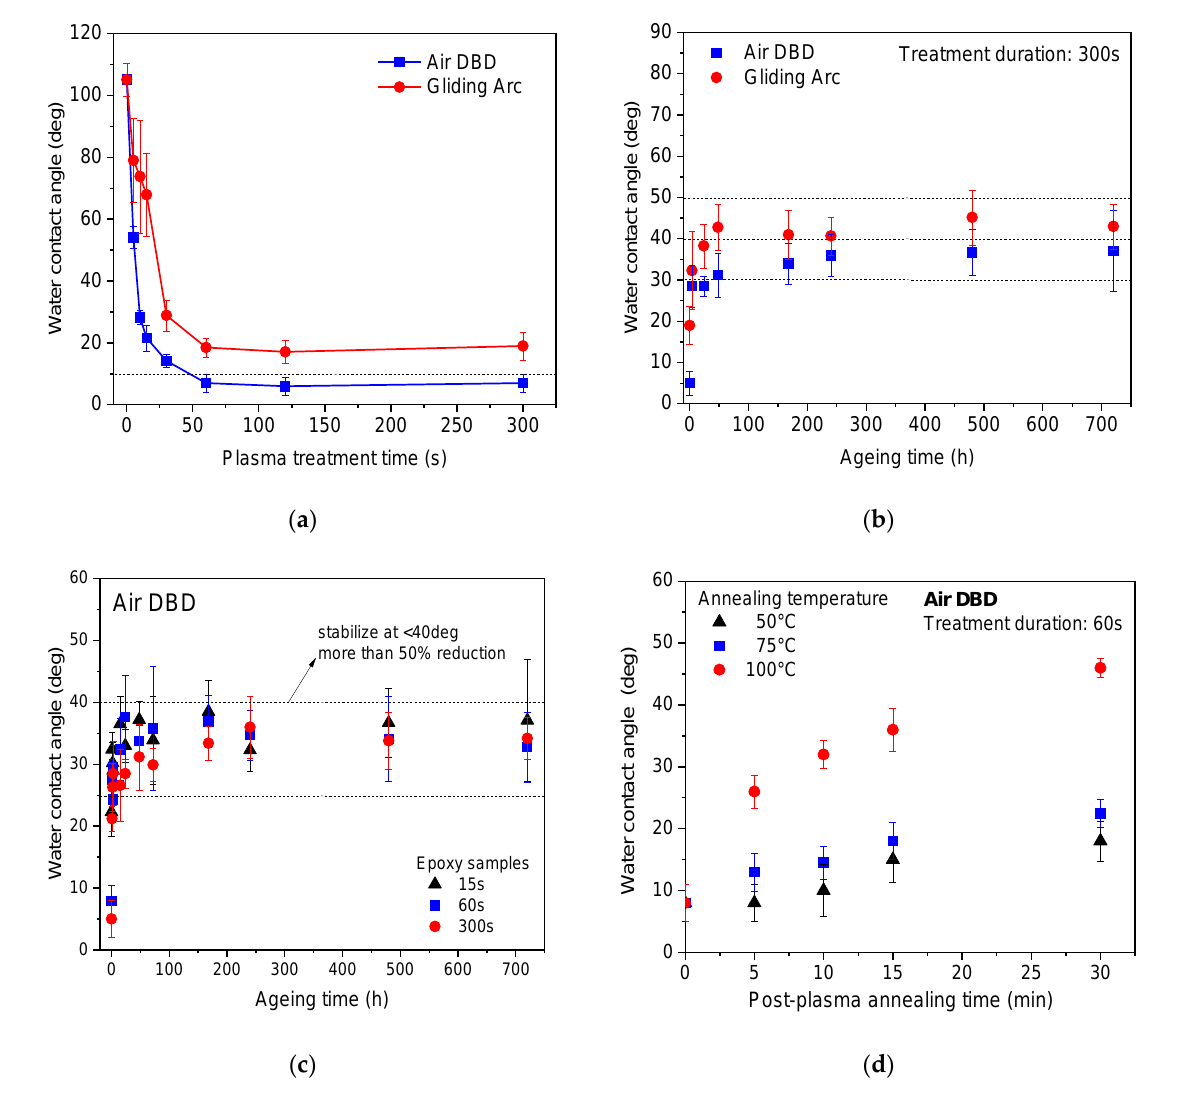
Figure 3. ( a ) Water contact angle of epoxy polymer surface as a function of the plasma treatment for air DBD and Gliding Arc, ( b ) Comparison of ageing effect on epoxy surface in air DBD and Gliding Arc, ( c ) WCA ageing for air DBD at different plasma treatment durations, and ( d ) Temperature effect on WCA ageing for 60 s of air DBD treatment (accelerated ageing).